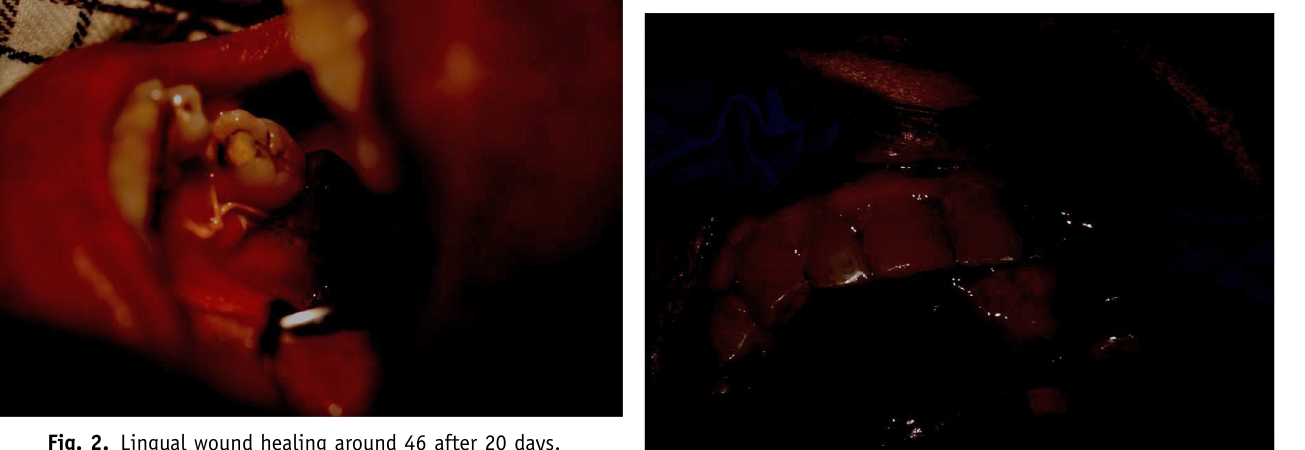
Fig. 2. Lingual wound healing around 46 after 20 days.